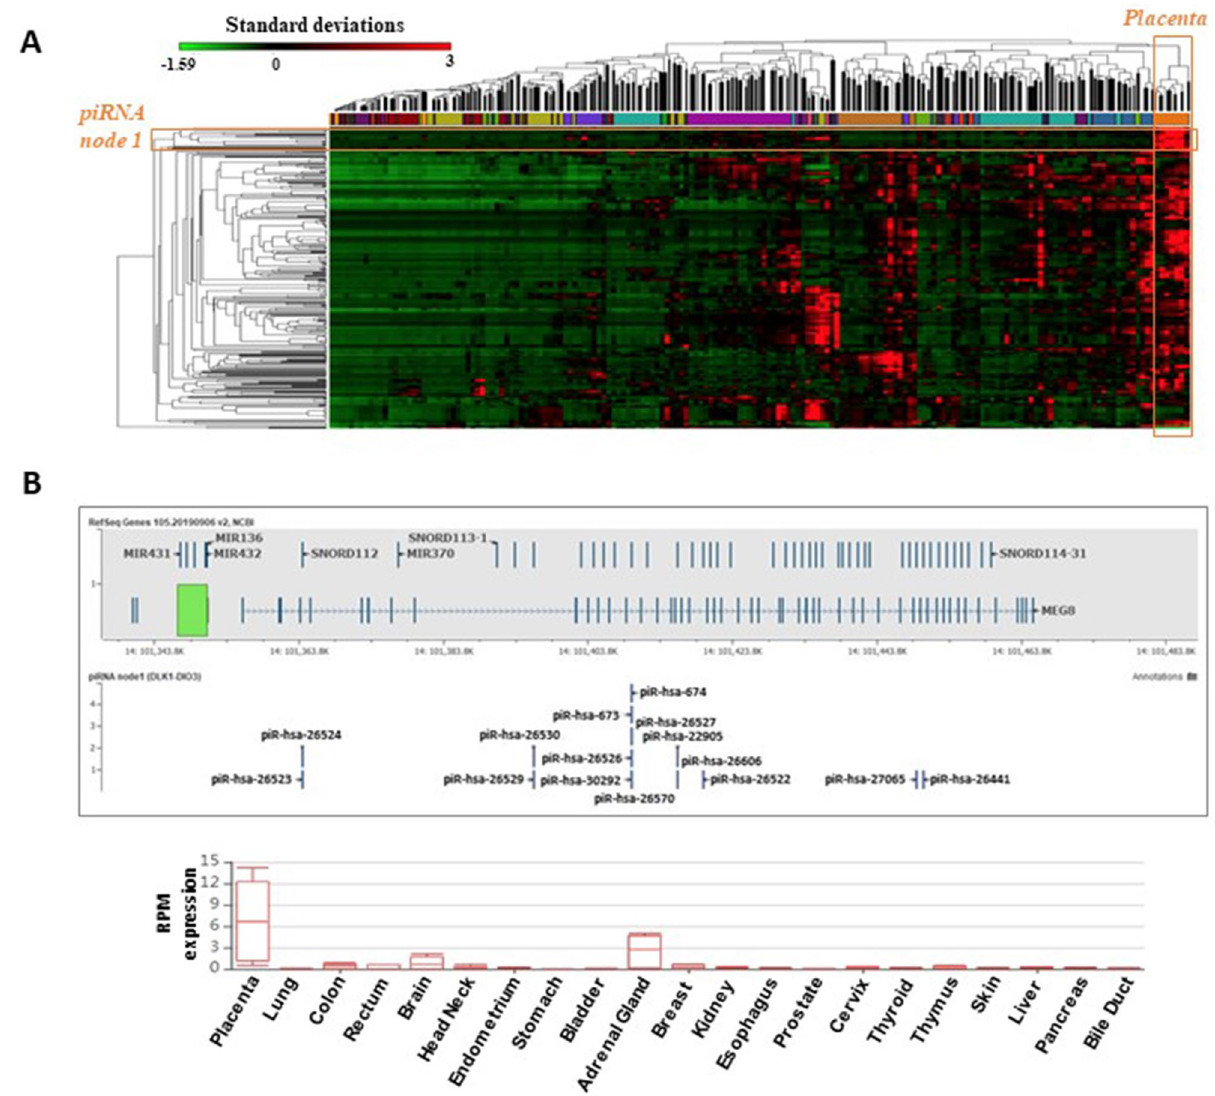
Figure 3. Expression of the 297 piRNAs in the placenta vs human somatic tissues. (A) An unsupervised hierarchical clustering of samples based on the expression of the 297 piRNAs expressed in placenta samples and their corresponding expression in human adult tissues. The analysis indicates that most of the identified piRNAs display higher expression in the placenta compared with other adult somatic tissues. (B) Comparison of the median expression of the 15 piRNAs from node 1 across human placenta and somatic tissues. The expression range (represented by a whisker plot with the median, 25th and 75th percentiles and maximum and minimum values) of the 15 piRNAs from node 1 across human placenta and somatic tissue (tissues described in the